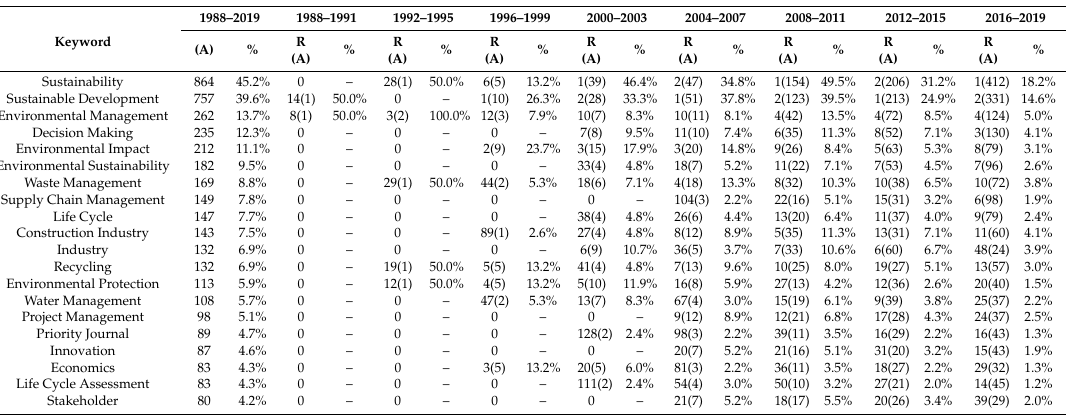
Table 8. Top 20 keywords (1988–2019).